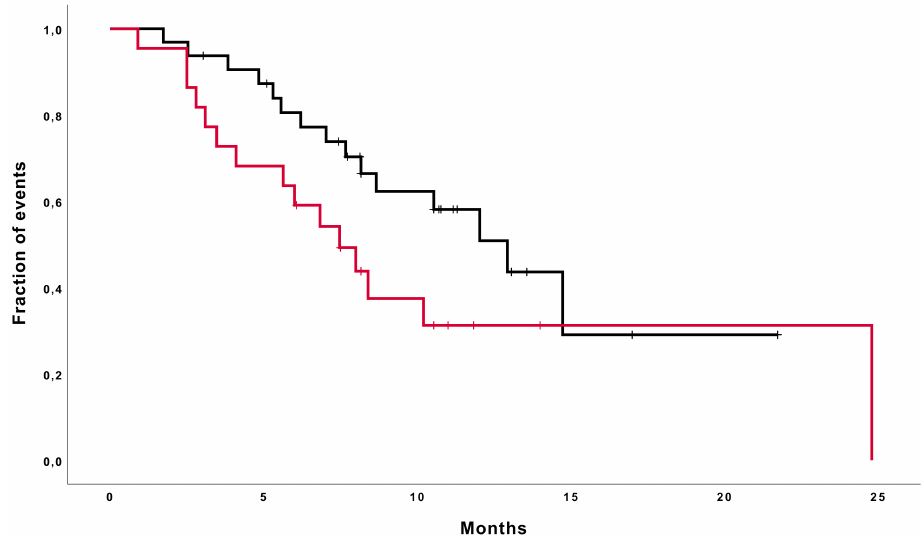
Figure 4. Median overall survival curves in patients taking (red line) or not taking (black line) steroids at baseline (7.4 months and 12.9 months, respectively; p = 0.09). Table 2. Univariate analysis for overall survival. Met = methylated; unmet = unmethylated; wt = wild-type; mut = mutated.